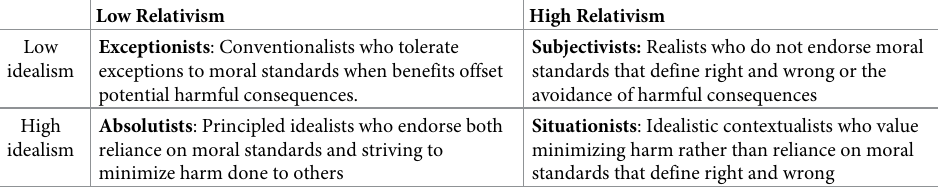
Table 1. The four moral types identified in